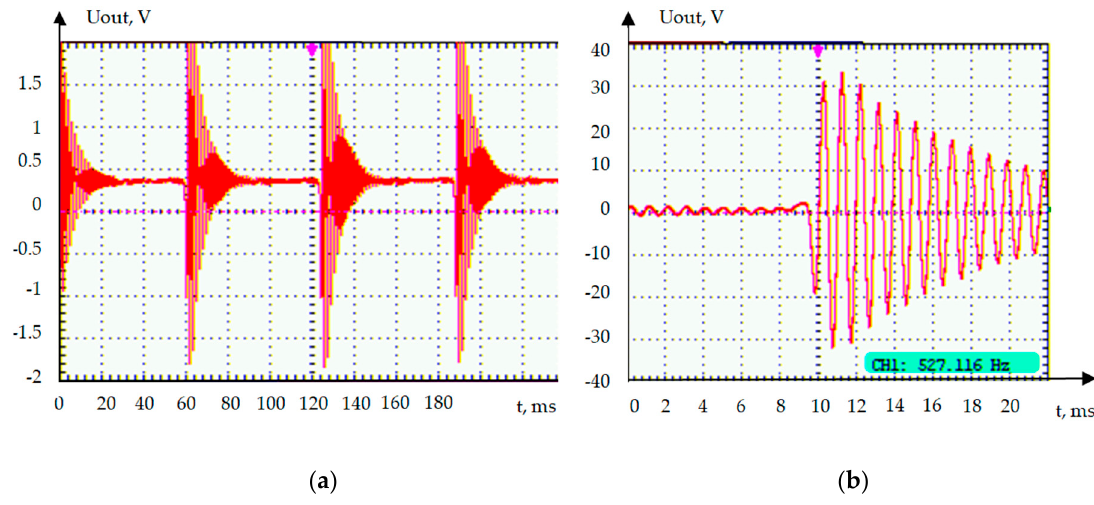
Figure 7. Form of the signals of the CKP sensors. ( a ) Metglas / PZT / Metglas; ( b ) Metglas / LiNbO 3 / Al.